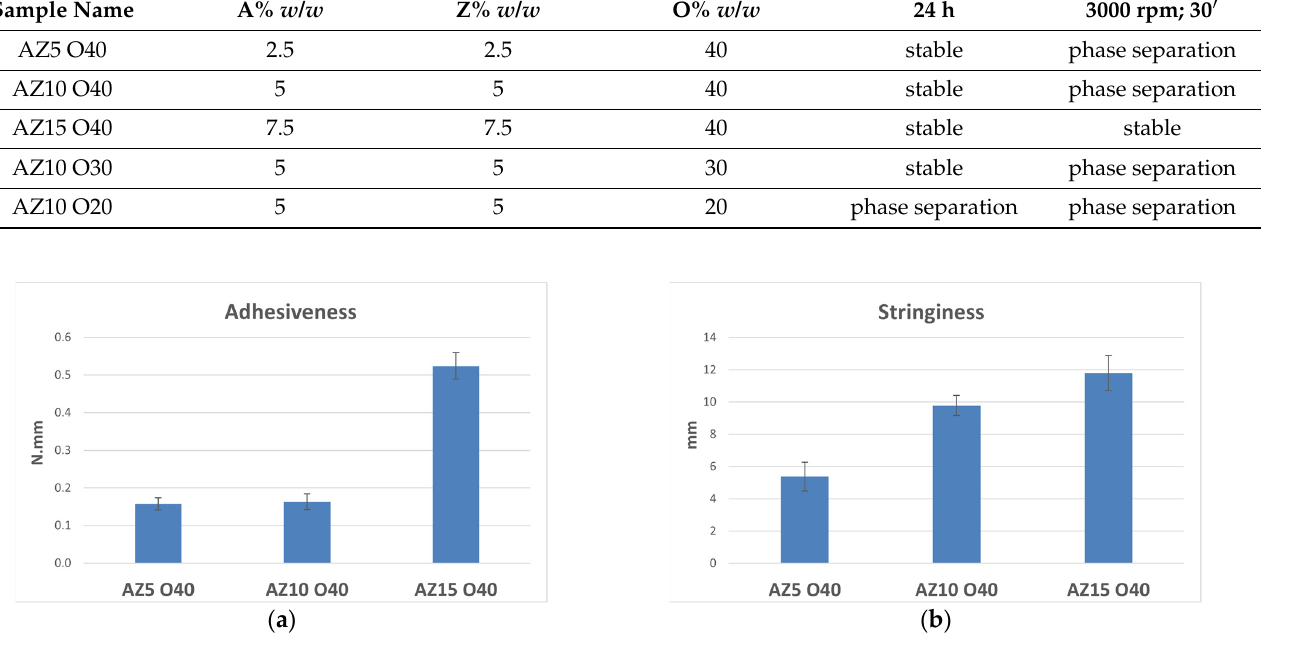
Figure 1. Textural parameters and standard deviations of adhesiveness ( a ) and stringiness ( b ) meas- ured by an immersion/de-immersion test for the emulsions prepared with A-Z associations (1:1) increasing the amount of the total solid phase (5–10–15% w/w) at fixed oil amount (40% w/w).